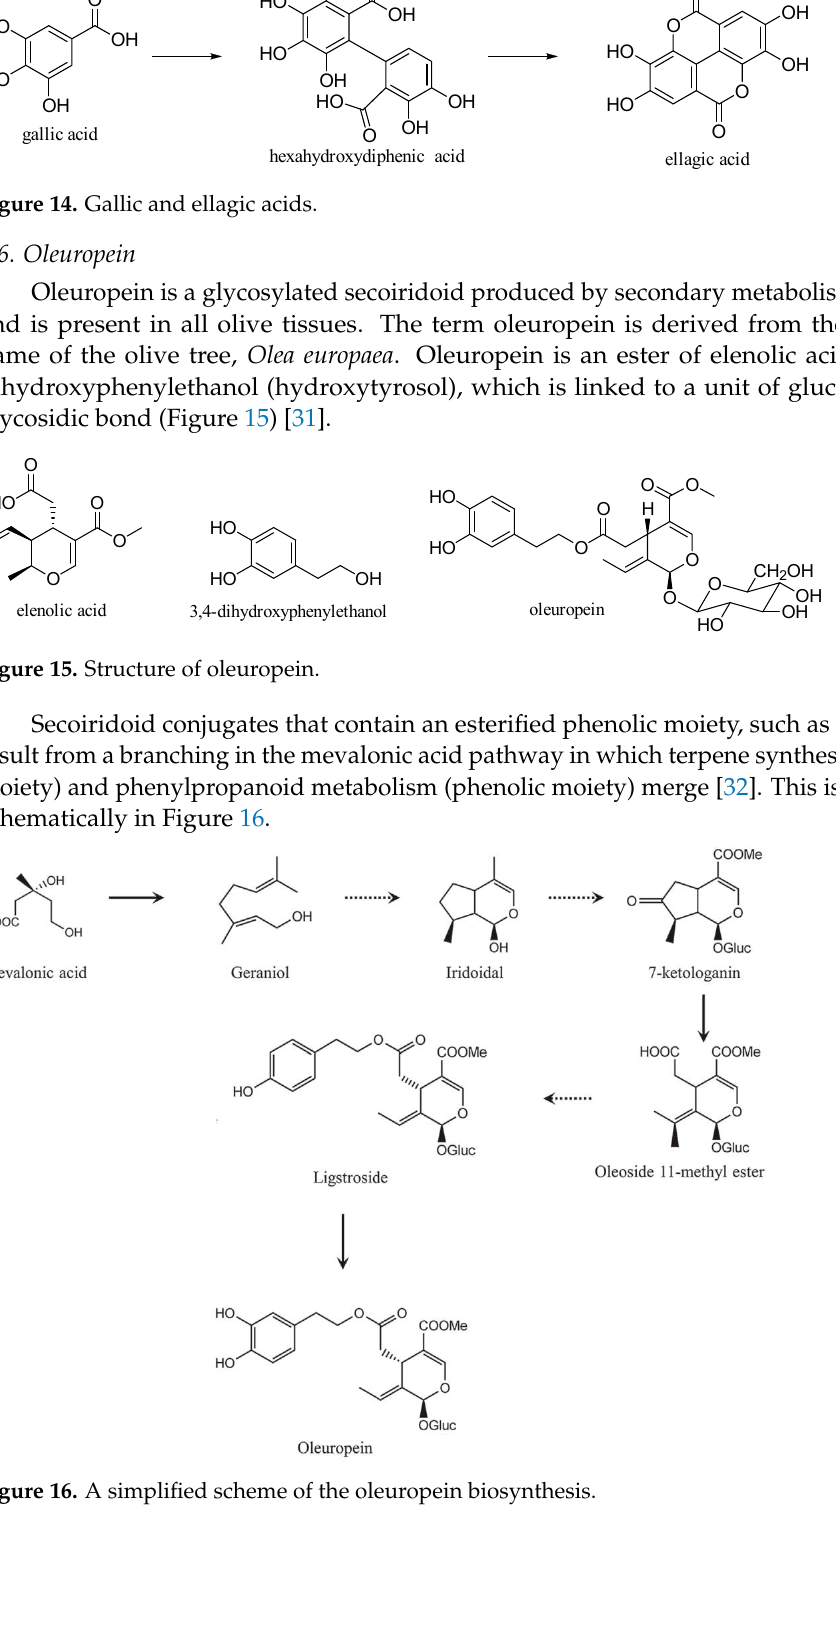
Figure 13. Structure of hesperidin .